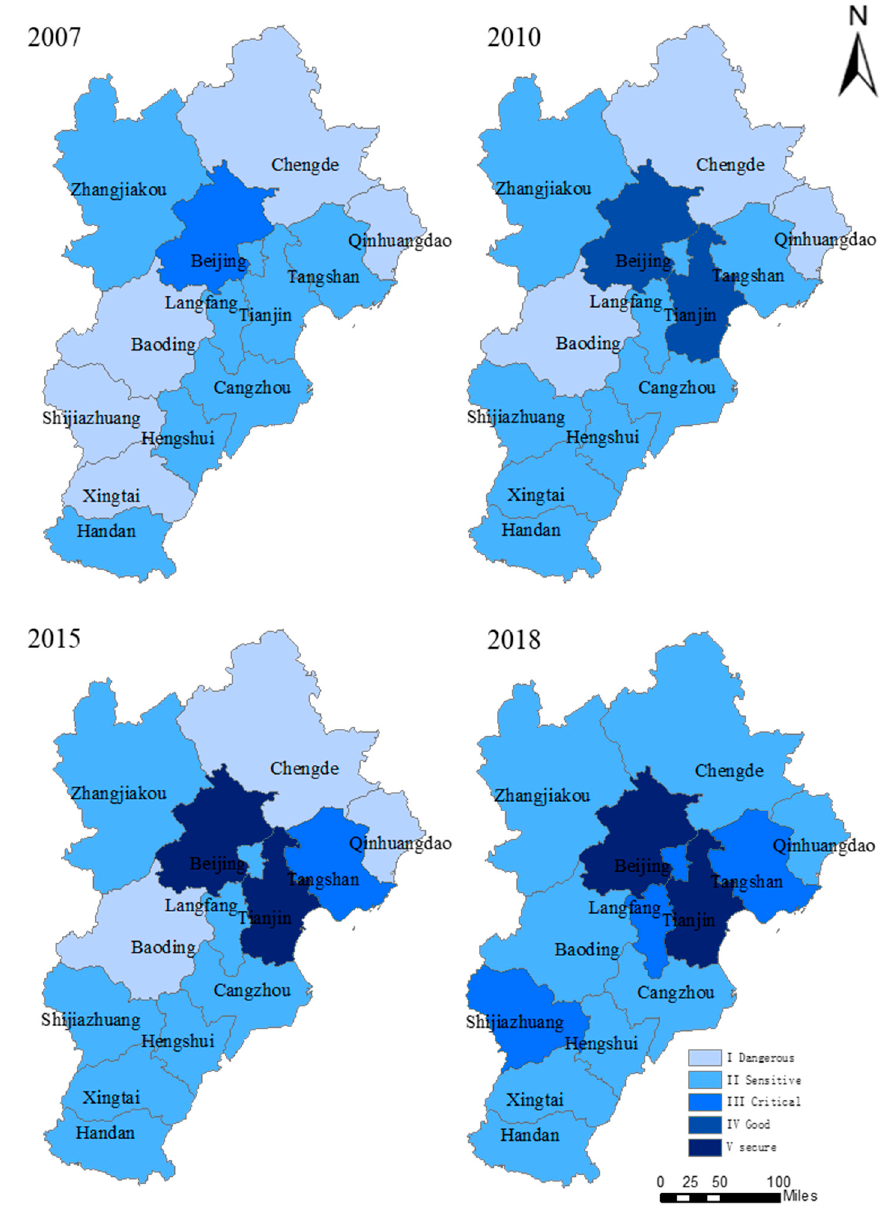
Figure 4. Spatial levels of LES in the BTH region in 2007, 2010, 2015 and 2018. Table 5. Main obstacle indicators of LES in the BTH region from 2007 to 2018 (%).